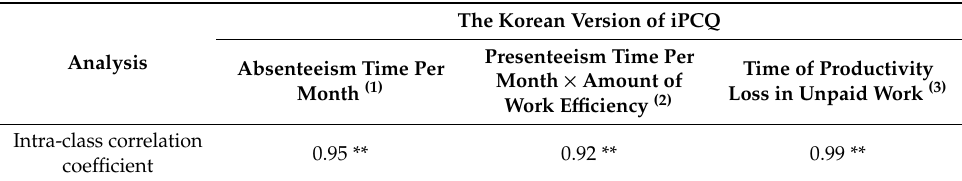
Table 3. Test–retest reliability results.